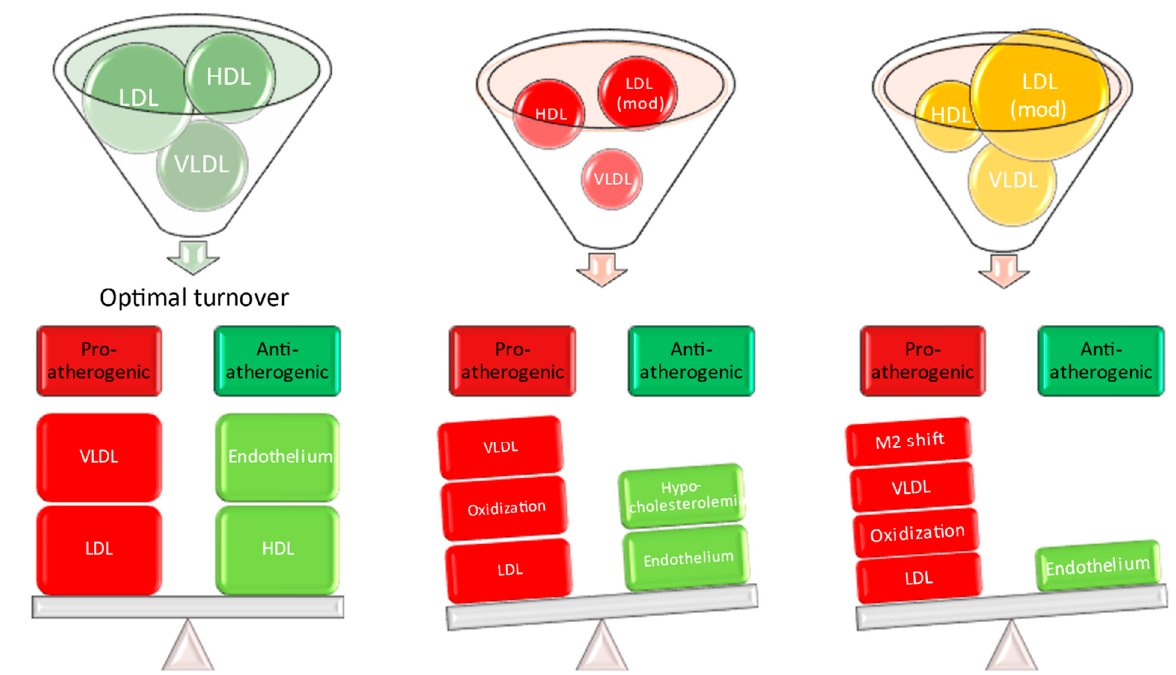
Figure 1. Acute sepsis causes profound disturbances in lipid profile while subsequent recovery has distinctive yet also abnormal profile.